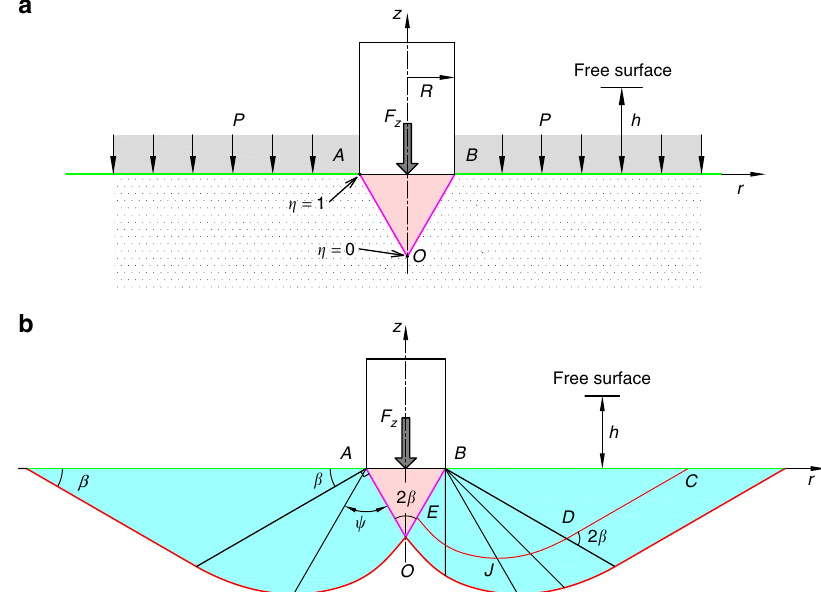
Fig. 4 The theoretical model. a The system includes the intruder and a conical SZ ahead of it. b Examples of the “ + ” (red lines) and “ − ” (black lines) characteristic paths in the rz plane, as well as their dependence on the angle β = π /4 − ϕ /2. α = 0 at the intruder ’ s bottom and − π /2 at the cone